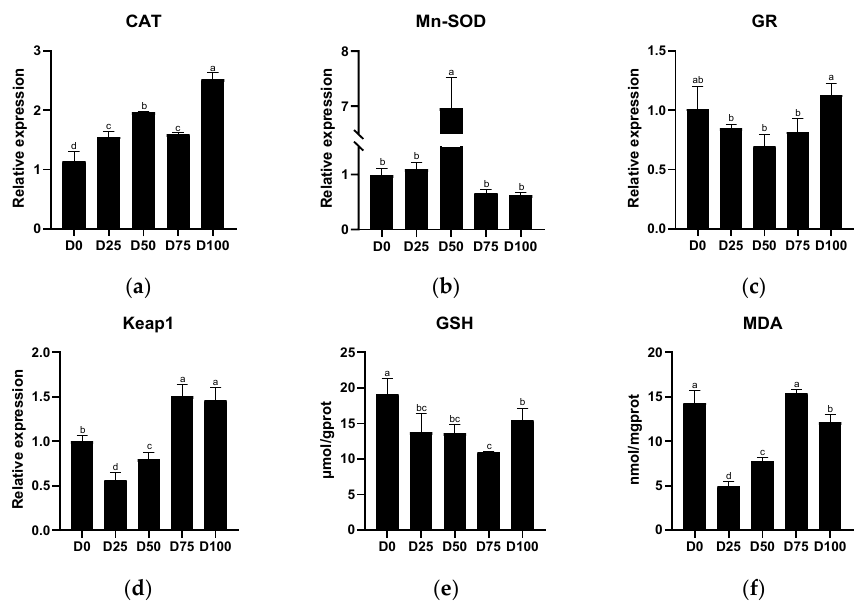
Figure 4. The effects of eugenol on antioxidant-related genes ( a ): CAT; ( b ): Mn-SOD; ( c ): GR; ( d ): Keap1, and antioxidant-related enzymes ( e ): GSH; ( f ): MDA, in the liver of greater amberjack under simulated transport conditions. Different letters above bars indicate significant differences at the 0.05 level.